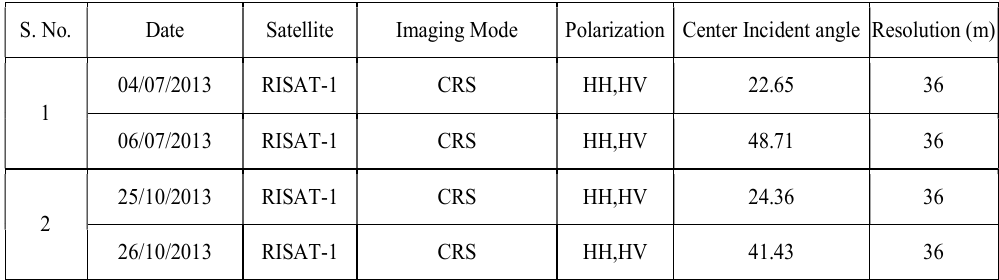
Table.1 details of acquired RISAT-1